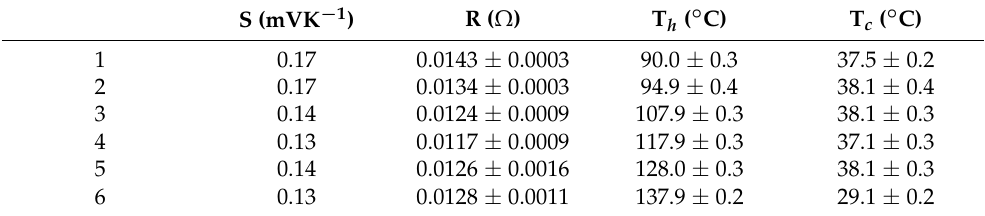
Table 2. Search Space Results. The four first parameters from left are fitting results and the two others measures fitting quality. S, R here are considered as the mean value for a single pn junction unit inside a